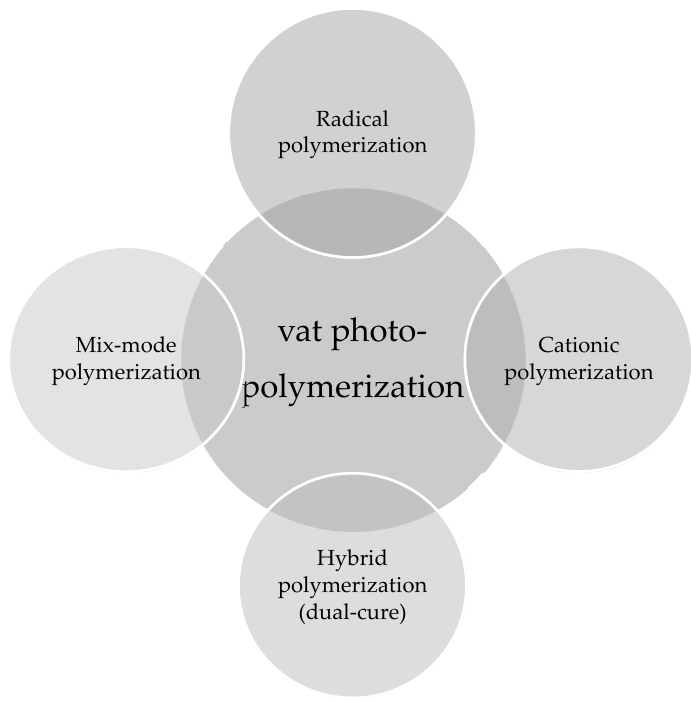
Figure 13. Reaction strategies for vat photopolymerization 3D printing.